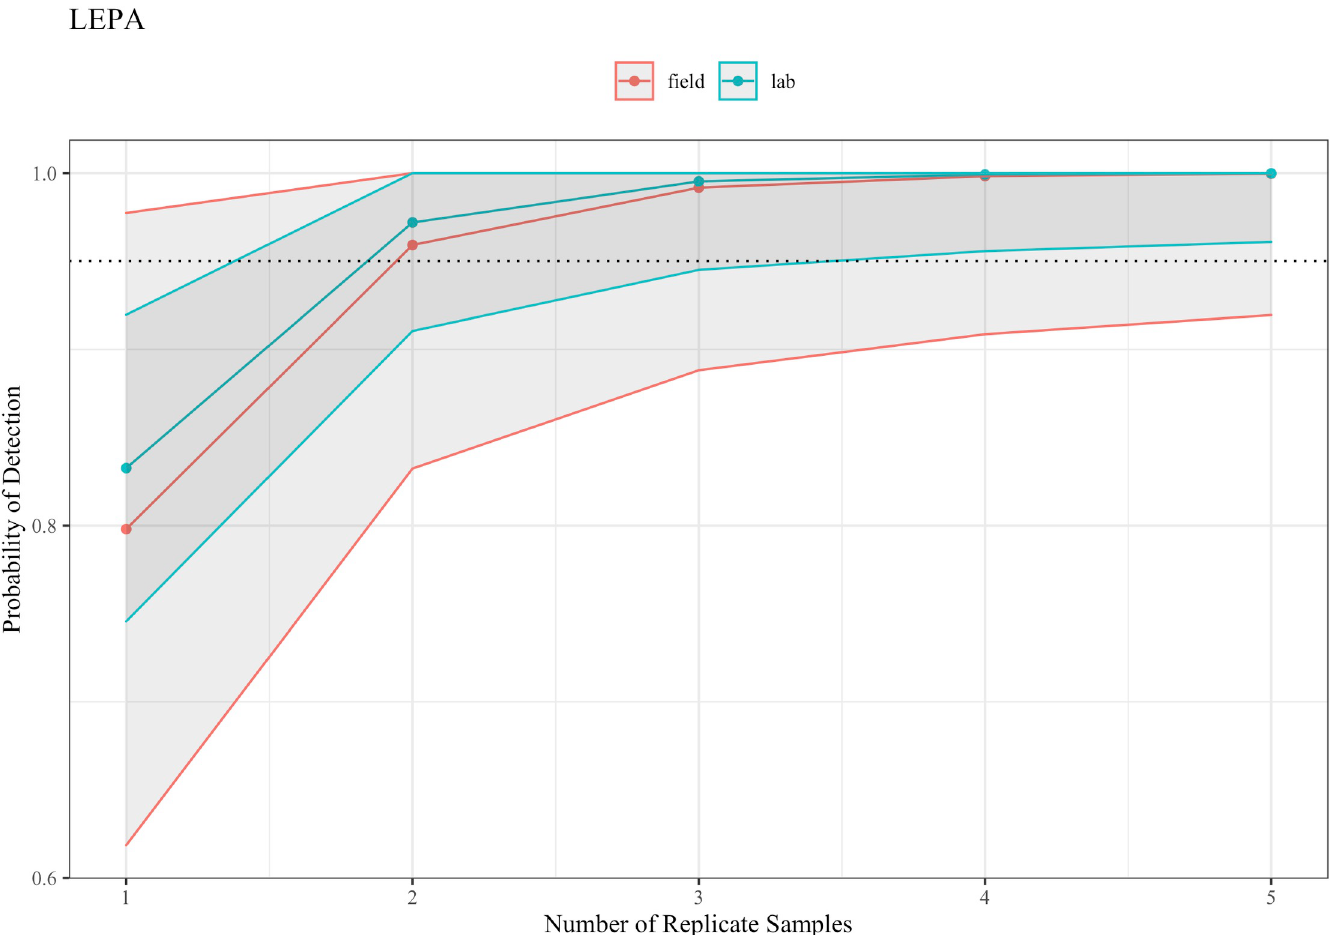
Fig 3. Probability of detecting LEPA using eDNA sampling per water replicate sampled. Dotted line represents 95% detection probability.